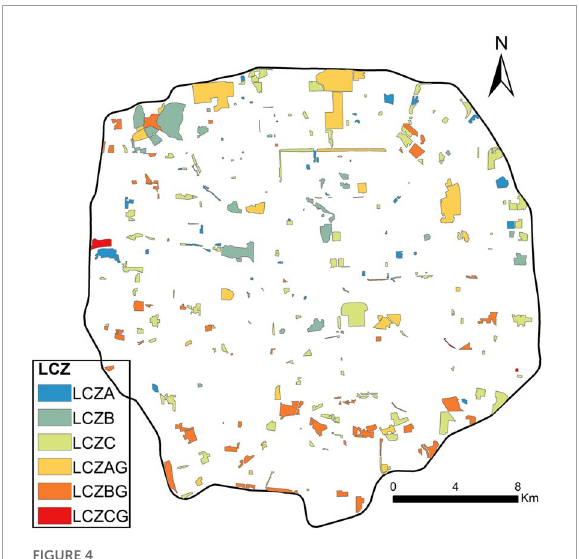
FIGURE4 The distribution of different types of urban